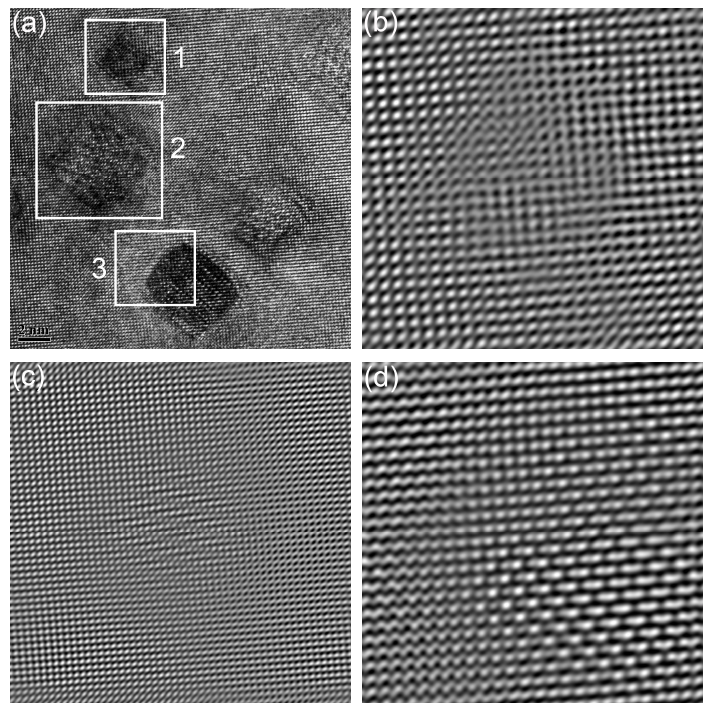
Figure 14. The interfaces between nanoparticles and matrix in the sample deformed at 1200 °C with strain rate of 0.001 s − 1 : ( a ) HRTEM graph of nanoparticles; ( b – d ) inverse FFT (IFFT) patterns obtained from the areas marked 1 to 3 in ( a ). Materials 2018 , 11 , x FOR PEER REVIEW 15 of 18